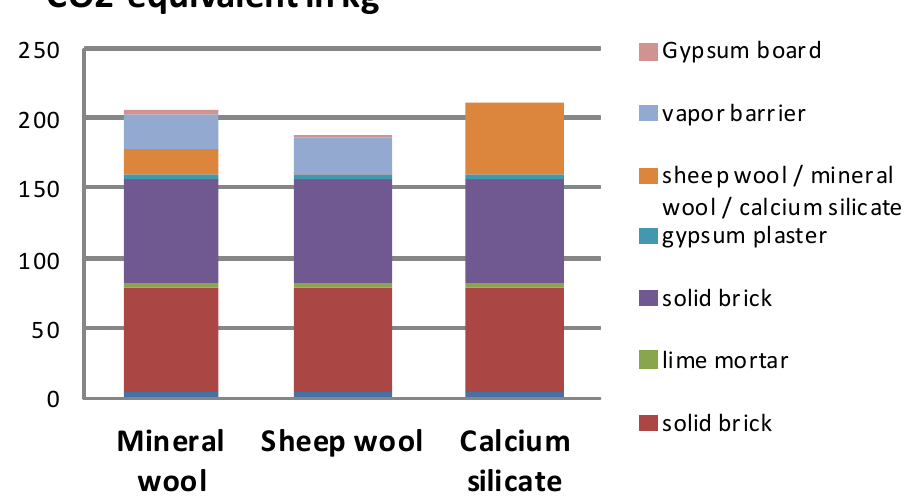
Figure 7. CO 2 equivalent in kg of the constructions with mineral wool, sheep wool and calcium silicate.